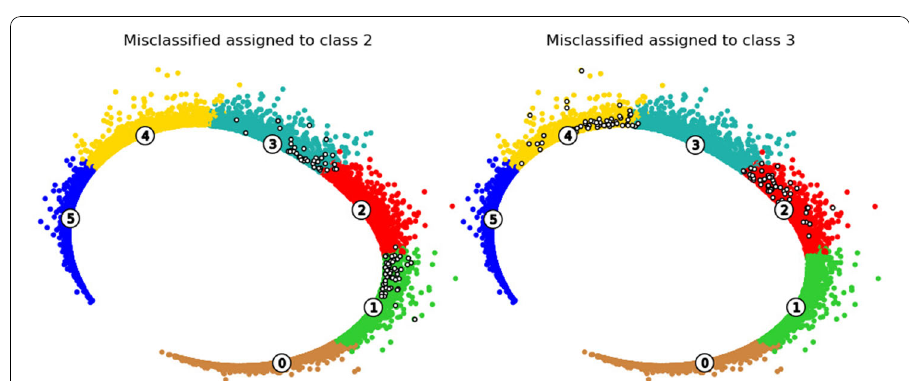
Fig. 11 Misclassified examples (classes 2 and 3)